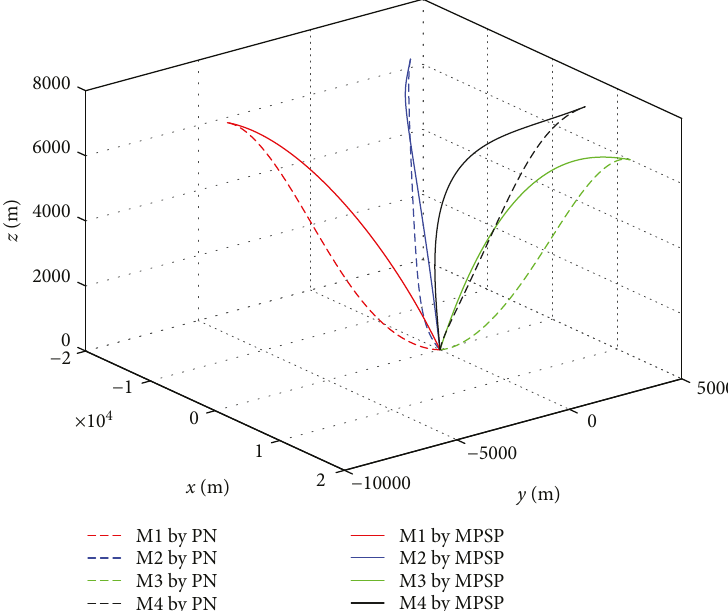
Figure 7: 3D trajectories with impact time control by MPSP.